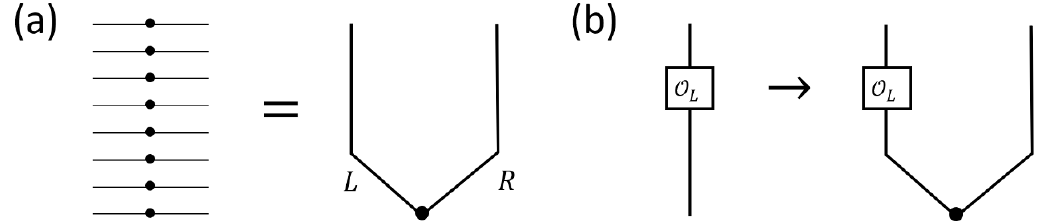
Figure 1 . Illustration of the puri(cid:12)cation procedure that maps operators to states in a doubled Hilbert space. (a) A maximally entangled state j 0 i (eq. (2.2) which can be viewed as many EPR pairs between the two systems. (b) The mapping between operator O and the corresponding state jOi obtained by applying O to the left system (see eq.